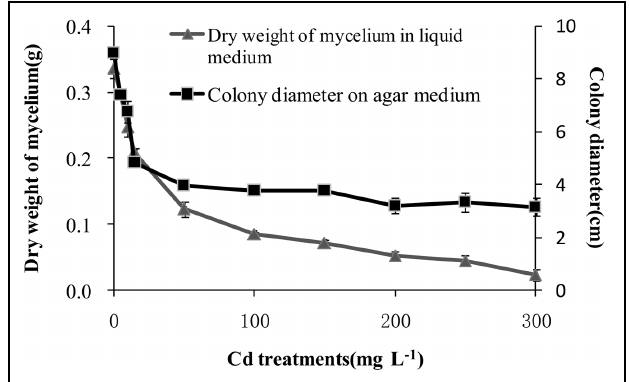
FIGURE 1 | Effect of Cd on the growth of Trichoderma reesei FS10-C. Values are mean ± SD of triplicate determinations.